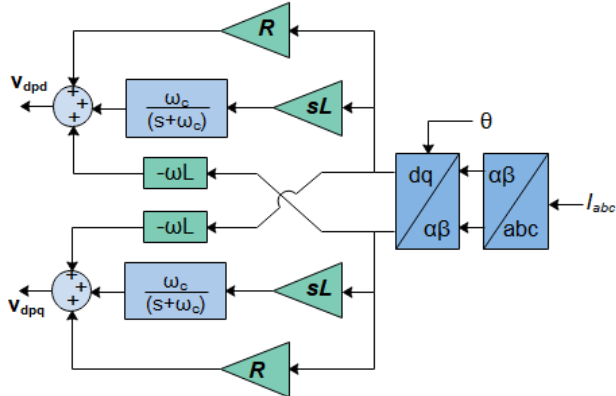
Figure 2. Proposed Virtual Impedance